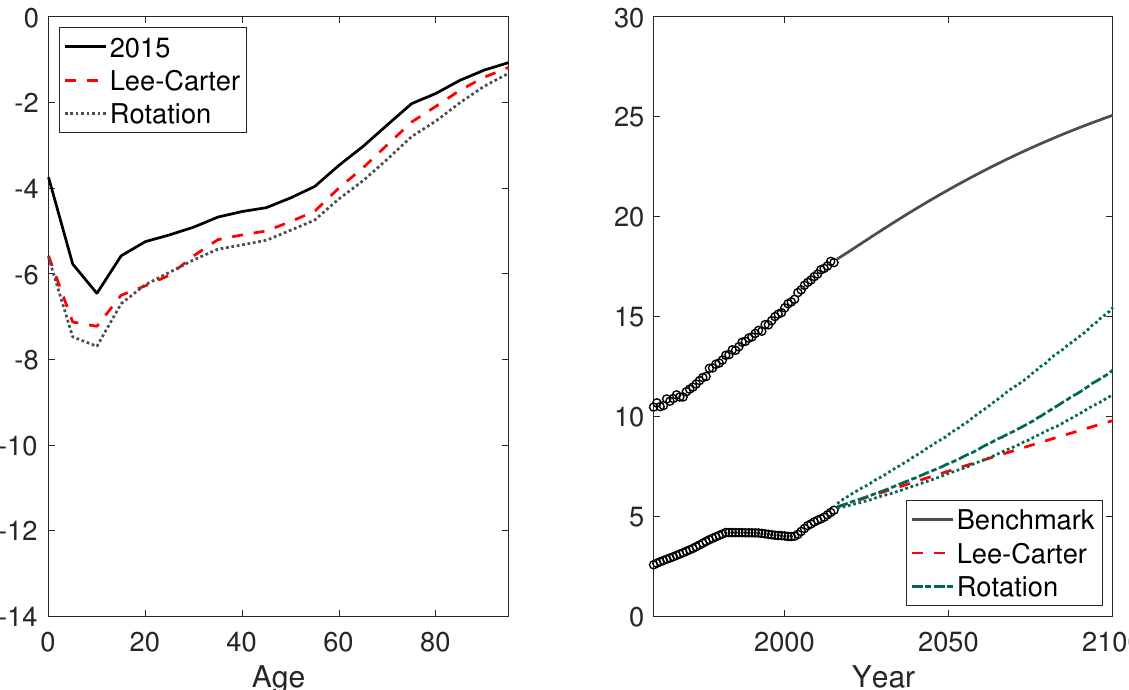
Figure 9. The projected logarithm age-specific death rates ( left panel ) and the remaining life expectancy at 65 ( right panel ) of the average of the benchmark countries and Nigeria using different models. For the rotation algorithm, the 2.5%, 50%, and 97.5% quantile of the projected e 65 are